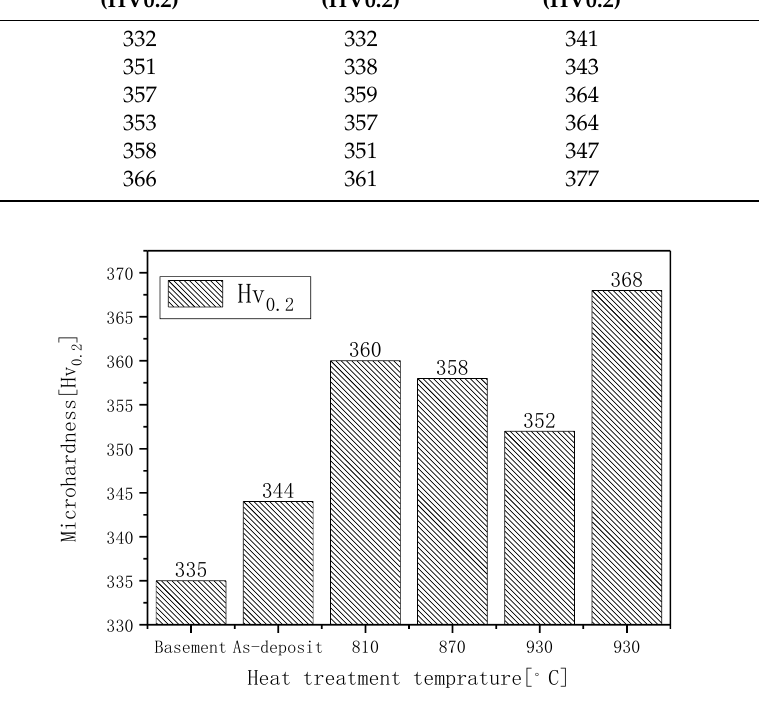
Figure 12. Relational curve of hardness and normalizing temperature.